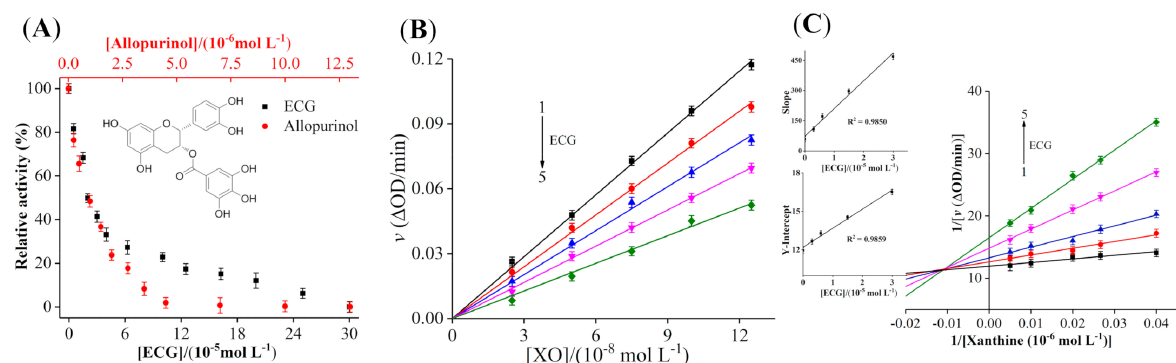
Figure 1. Inhibition analysis. ( A ) The effects of epicatechin gallate (ECG) and allopurinol on the activity of xanthine oxidase (XO) (pH 7.4, T = 25 ◦ C). c (XO) = 0.075 µ M, c (xanthine) = 50.0 µ M; ( B ) the plots of ν versus [XO]: c (xanthine) = 50.0 µ M, c (ECG) = 0, 4.0, 8.0, 15.0 and 40.0 µ M for curves 1 − 5, respectively; ( C ) the Lineweaver–Burk plots of XO in the presence of ECG. c (XO) = 0.075 µ M, c (ECG) = 0, 4.0, 8.0, 15.0 and 40.0 µ M for curves 1 → 5, respectively. The plots of slope and Y–intercept vs. ECG were inserted to the